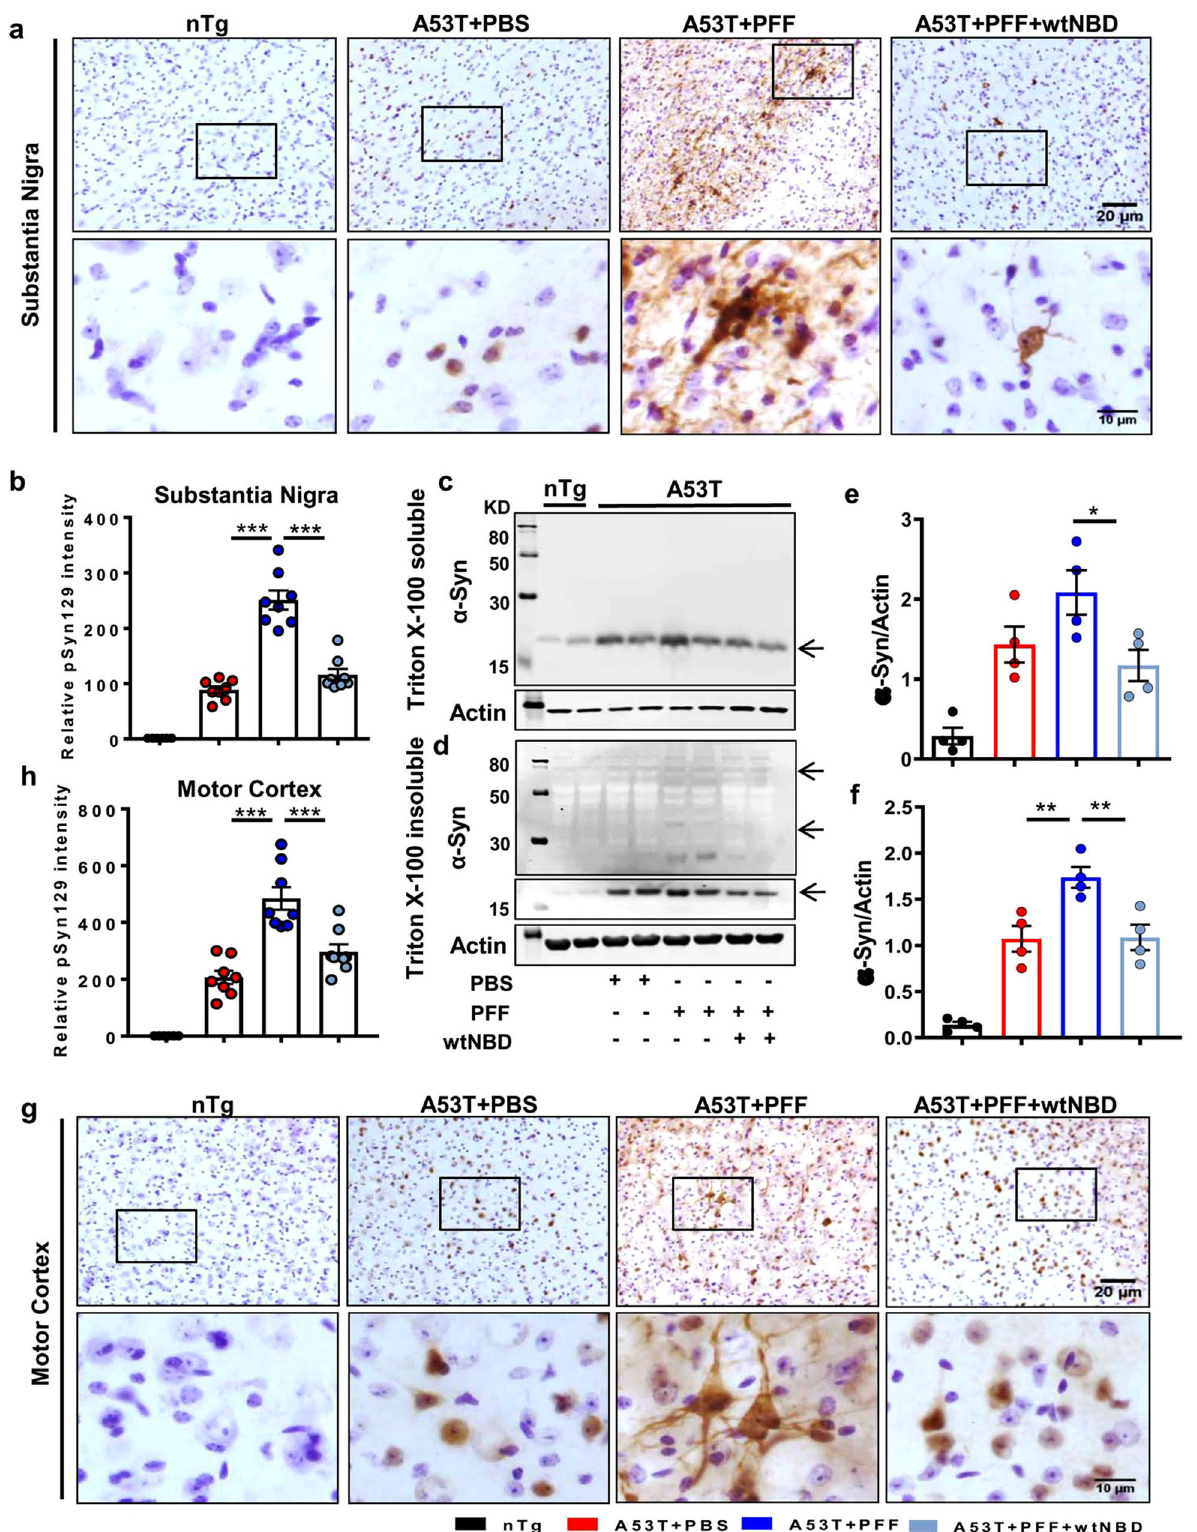
environment hostile for the surviving DAergic neurons 27 – 29 . An overwhelming level of α -syn leads to the secretion of this protein from neurons 30 – 33 , which then activates microglia via activation of NF- κ B activation and upregulation of proin fl ammatory molecules 34 . In addition, astroglial activation during the course of PD progression happens via reactive microglia-derived factors 16